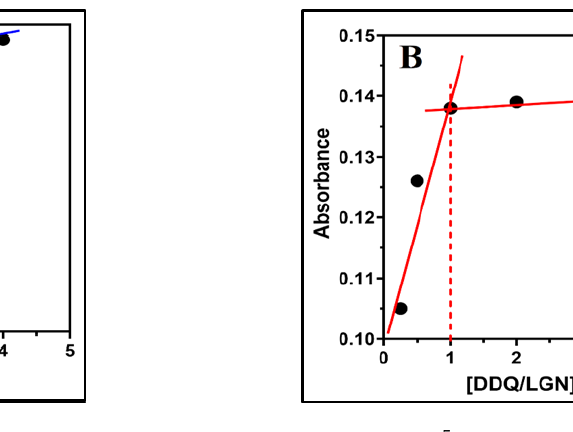
Figure 6. Spectrophotometric plot of LGN (6 × 10 – 5 M) complexes: ( A ) LGN-DDQ and ( B ) LGN-CHA Spectrophotometric plot of LGN (6 × 10 –5 M) complexes: ( A ) LGN-DDQ and complexes in MeCN (λ abs for DDQ (3 × 10 – 5 M)) complex (487.52 nm) and CHA (3 × 10 – 5 M) com- ( B ) LGN-CHA complexes in MeCN ( λ abs for DDQ (3 × 10 –5 M)) complex (487.52 nm) and CHA plexes. (3 × 10 –5 M)